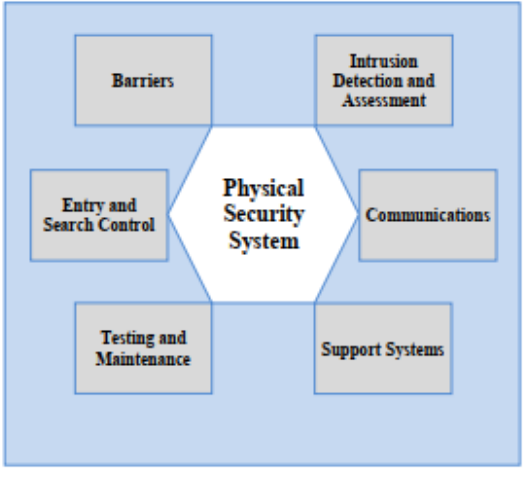
Figure 1. Physical Security Systems Components [6]